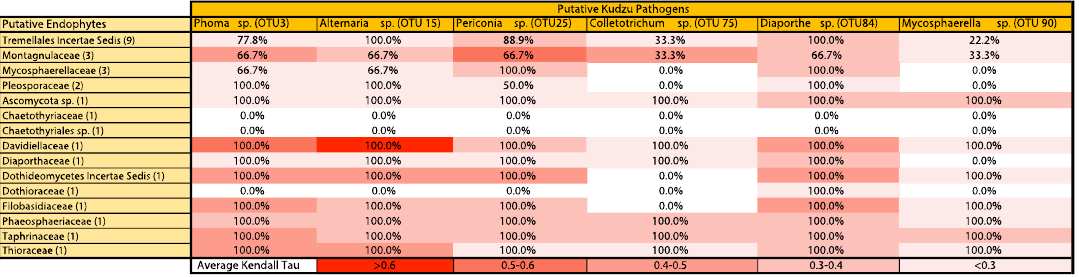
Figure 3. Heat map indicating the percentage of significant endophytic OTUs within each family (rows; total number of tested OTUs with families are shown parenthetically) that are significant and positively associated with pathogens (columns, with OTU number presented parenthetically) Average Kendall’s tau correlation coefficients for all significant correlations are used for color demarcation (see last row).